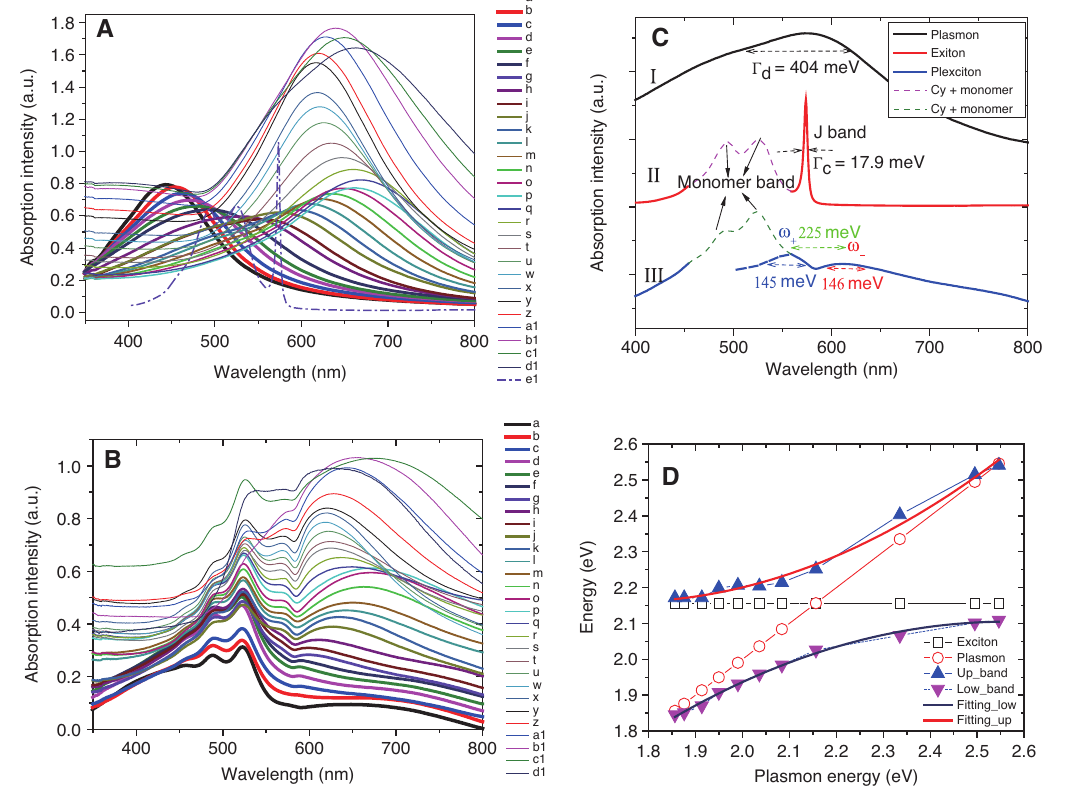
solution from 70 μ l Figure 2: (A) UV-visible absorption spectra of Au hollow nanostructures prepared by adding different amounts of HAuCl 4 to 800 μ l to the Ag colloids every 10 min (black line a indicates pure Ag colloids; b–q correspond to the addition of HAuCl solution at 90, 4 85, 80, 75, 70, 75, 80, 85, 90, 95, 100, and 150 μ l; q–y correspnd to the addition of HAuCl solution at 500, 400, 300, 500 μ l; y–d1 refer 4 to the addition of 800 μ l of HAuCl solution). (B) Typical experimental absorption spectra of HNSs doped with J-aggregate with different 4 thicknesses of the Au shell corresponding to (A). Absorption spectra of the HNS with LSPR at 575 nm strongly coupled to J-aggregates. (C) UV-visible absorption spectra of (I) a bare HNS with surface plasmon resonance at 576 nm, (II) pristine 1,1 ′ -diethyl-2,2 ′ -cyanine iodide (Cy + ), J-aggregates, and (III) HNS/J-aggregate ensembles. (D) Experimental dispersion curves of the hybrid state energies for the first SC are plotted as a function of their corresponding plasmon resonance. Anticrossing analysis of the plexciton with upper branch ω (blue triangular + symbol) and lower branch ω (pink triangular symbol); the circle and square patterns illustrate the exciton and plasmon, respectively. Here − the Rabi splitting of the first SC is 225 meV, and that of the second SC is approximately 180